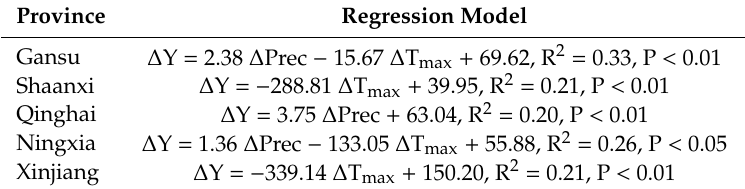
Table 3. Multiple linear regression models established in di ff erent provinces of northwest China.